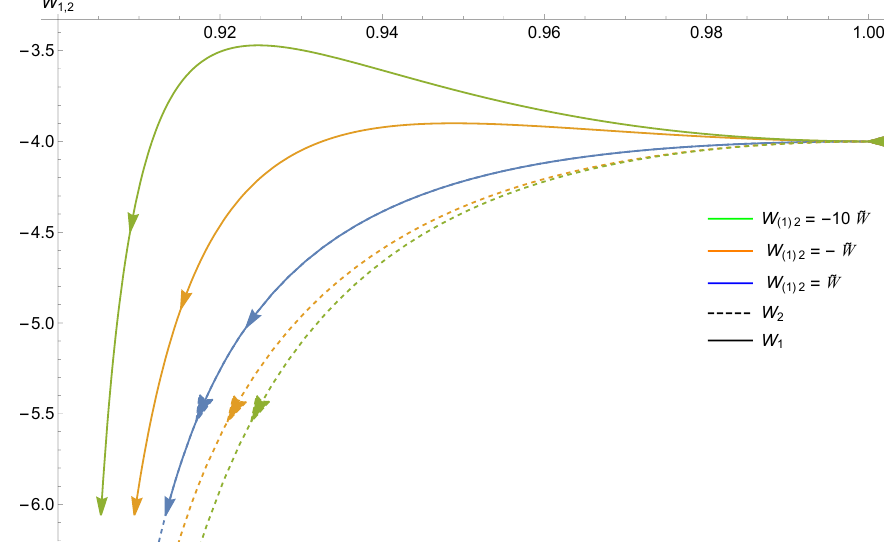
Figure 3 . Plot of the superpotentials W 1 , W 2 as functions of ϕ for different choices of α , defined in (6.6), in the case of a Nut IR end-point. The IR endpoint for this plot has been chosen to be at ϕ = 0 . 9 . The direction of the flow is indicated in the figure: it starts from the UV fixed point 0 and ends in the IR. The different lines correspond to different choices of the integration constant . The constant ˜ W is defined in (6.7). Note that when we choose W W (1)2 coincide and the slice geometry in this case is that of a round S 3